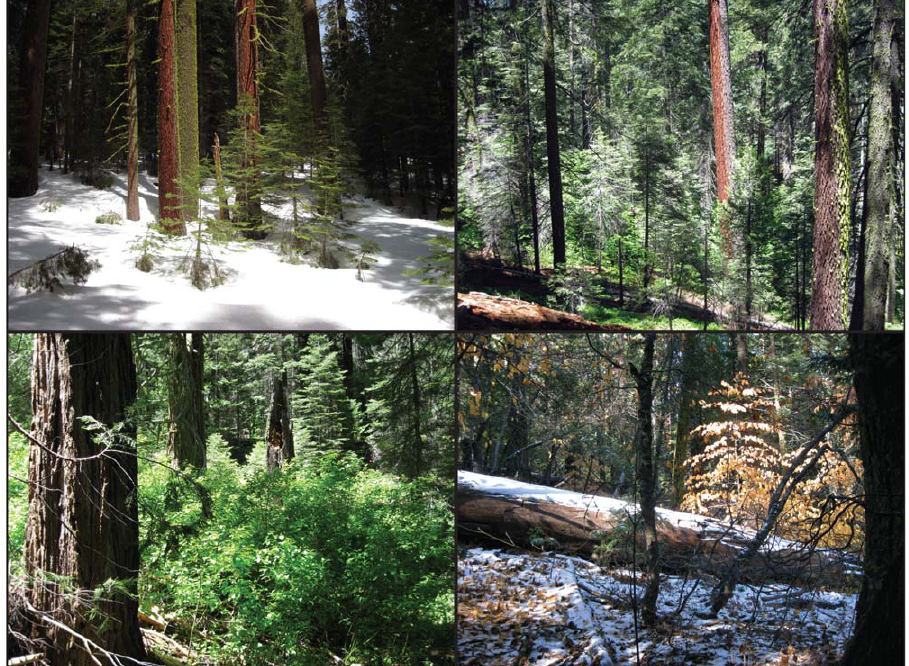
Figure 7. Structure and composition of the Yosemite Forest Dynamics Plot (YFDP). Four images from different parts of the YFDP illustrate defining characteristics of the ecosystem. Most precipitation falls in the winter as snow yielding a spring snowpack of approximately 1 m (upper left image, April 11, 2011). The forest is composed of an overstory of large-diameter trees with abundant but heterogeneous shrub and herbaceous layers (upper right image, June 22, 2009). Shrubs can be locally dense enough to reduce tree recruitment (lower left image, June 22, 2009). Although most trees and shrubs are evergreen, the presence of the deciduous species Cornus nuttallii and Quercus kelloggii results in seasonal openings in the canopy (lower right image, November 11, 2010). All photos by J. A. Lutz.